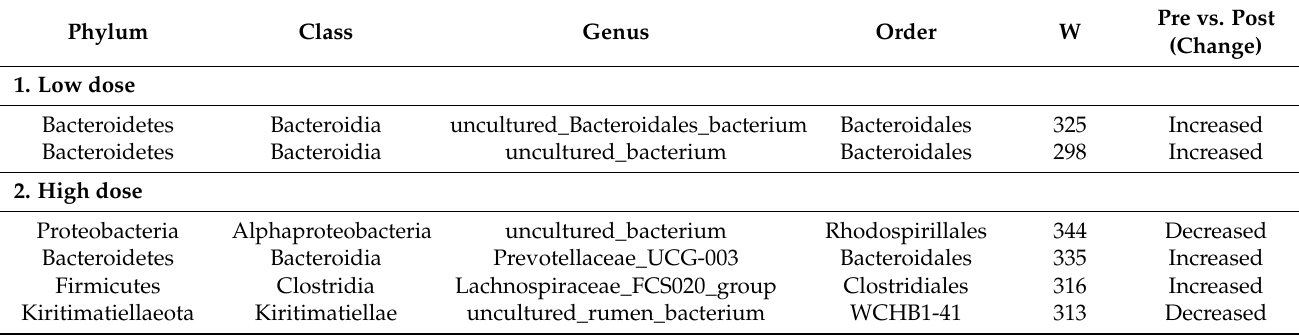
Table 6. Results of ANCOM analysis showing that bacterial genera are significantly different between pre- and post- treatment samples of low and high dosing regimens. High W values indicate significant differences in abundance levels between